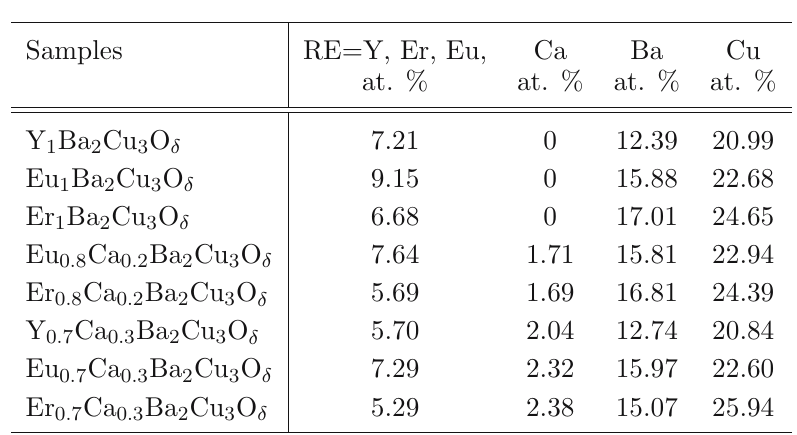
Table 1 EDX data of RE